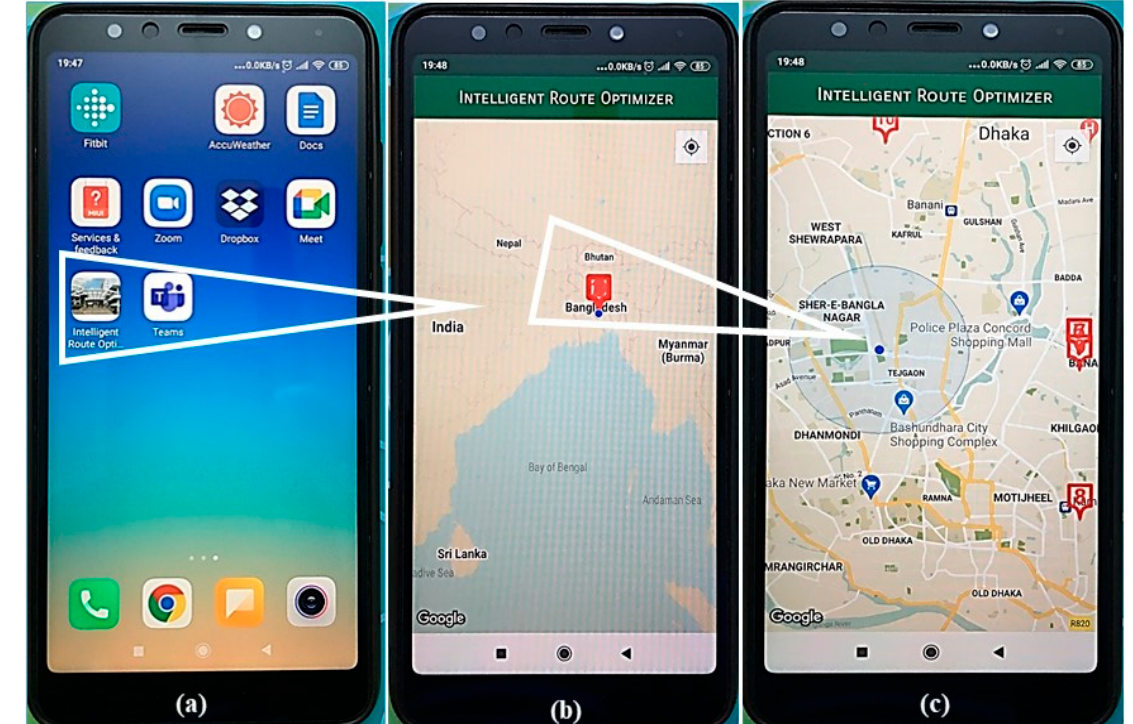
Figure 9. Overview of intelligent route optimizer showing ( a ) icon of the application ( b ) user application interface ( c ) current user location on the Google map.